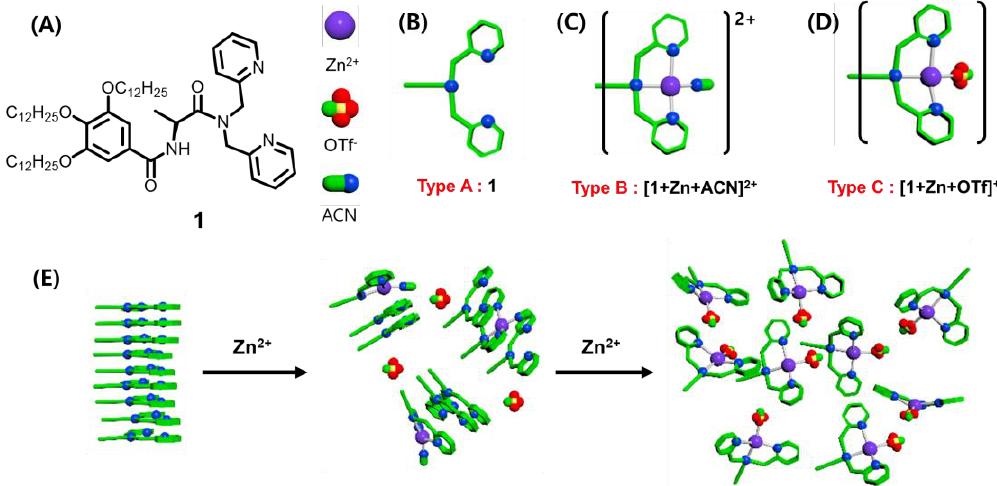
Figure1. ( A )Chemicalstructureofgelator 1 . Proposedstructureof( B )freeligand, ( C )[1 + Zn 2 + + ACN] 2 + , Figure 1. ( A ) Chemical structure of gelator 1 . Proposed structure of ( B ) free ligand, ( C ) and ( D ) [ 1 + Zn 2 + OTf - ] + ; A type without Zn 2 + , B type at 0.1–0.4 equiv. of Zn 2 + , B and C types at 0.5–0.7 [1+Zn 2+ +ACN] 2+ , and ( D ) [ 1 +Zn 2+ OTf - ] + ; A type without Zn 2+ , B type at 0.1–0.4 equiv. of Zn 2+ , B and C equiv. of Zn 2 + and C type at above 0.8–1.0 equiv. of Zn 2 + ( E ) The illustration of the expected structure types at 0.5–0.7 equiv. of Zn 2+ and C type at above 0.8–1.0 equiv. of Zn 2+ ( E ) The illustration of the conformation at di ff erent amount of Zn 2 + expected structure conformation at different amount of Zn 2+ .